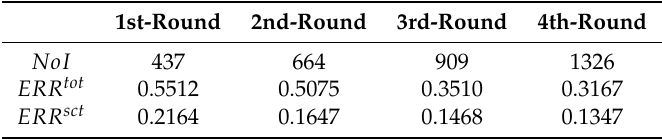
Figure 6. ( a ) The real part ( first row ) and imaginary part ( second row ) of the exact profile. ( b – e ) Reconstructed results correspond to fourth rounds of optimization, respectively. The real ( first row ) and imaginary ( second row ) of the reconstructed results. The 1st, 2nd, 3rd and 4th rounds of optimization correspond to β being 6, 3, 0.5 and 0, coupled with M w being 64, 128, 256, and 1024, respectively. Table 4. Errors of the reconstructed results by